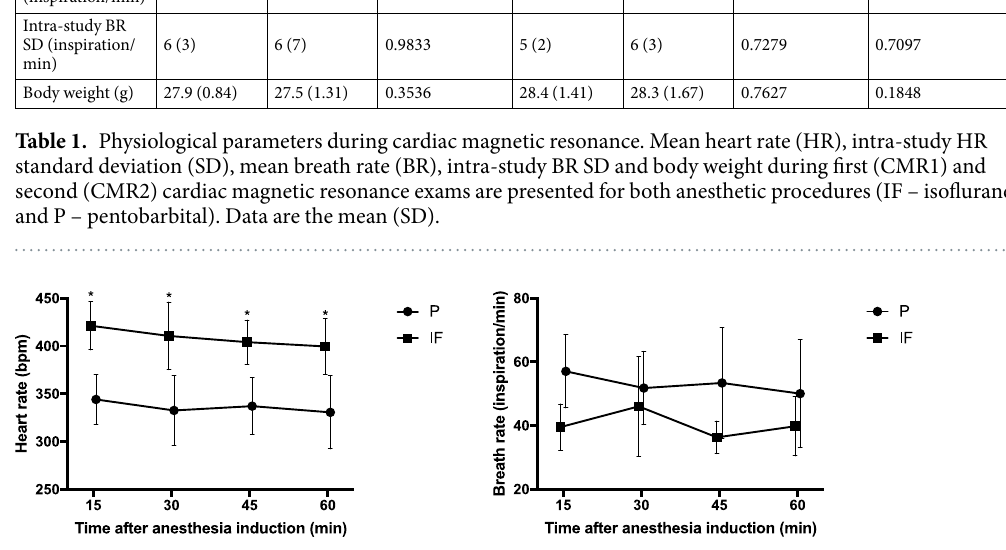
Figure 1. Heart rate (left panel) and breath rate (right panel) profiles during CMR examinations. Data are the mean ± SD (error bars) of HR and BR in animals from groups IF (isoflurane) (black squares) and P (pentobarbital) (black circles), measured every 15 minutes after anesthesia induction throughout the CMR procedure. * p < 0.05 between